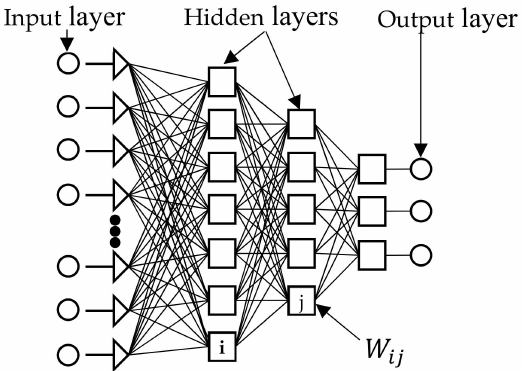
Figure 2. Illustration of an MLP